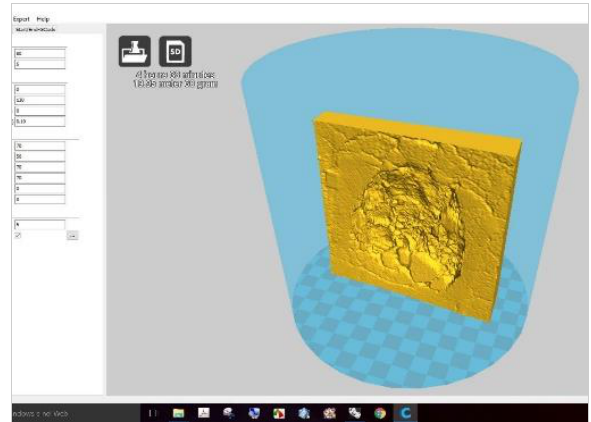
Figure 6. The main screen of Cura; the pothole model, normal view